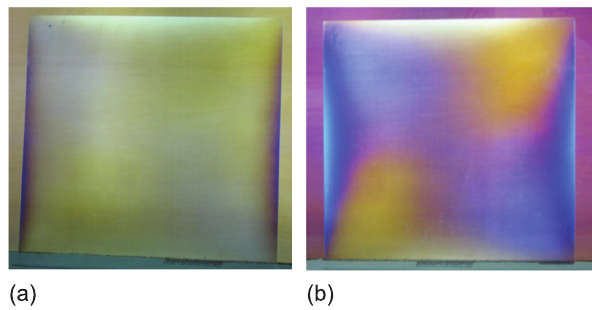
Fig. 8: Distribution of stresses in the: a) primary glass, b) glass refined wit alumina